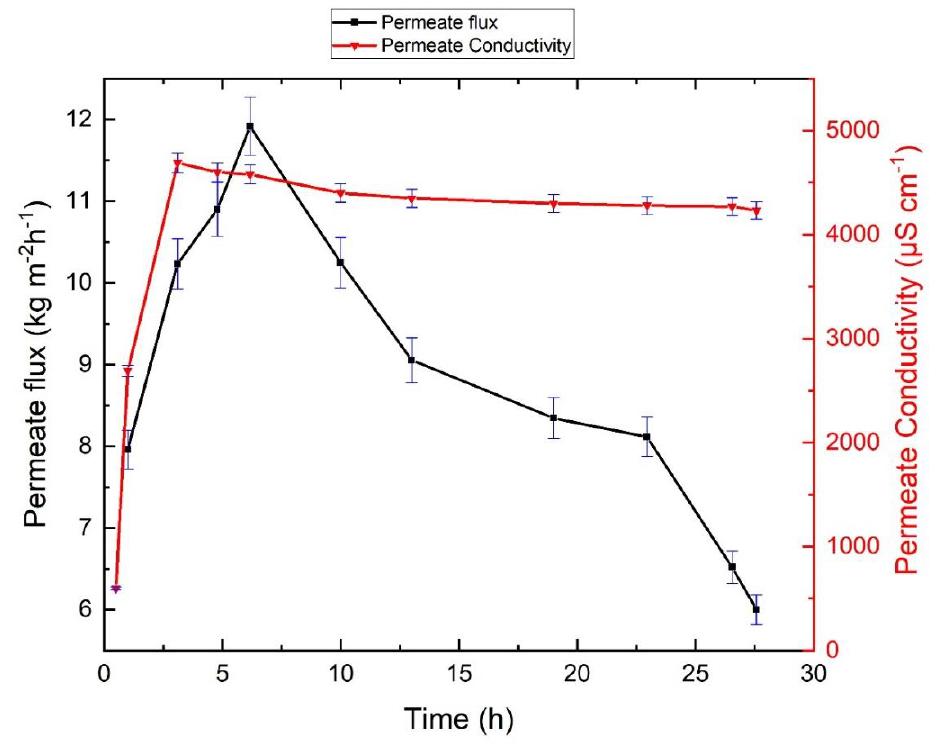
Figure 7. Effect of forced (i.e., high-pressure) wetting on system performance. Operation of the process above liquid entry pressure (LEP) led to rapid passage of liquid feed to the permeate side of the membrane, which drastically increased permeate electrical conductivity.